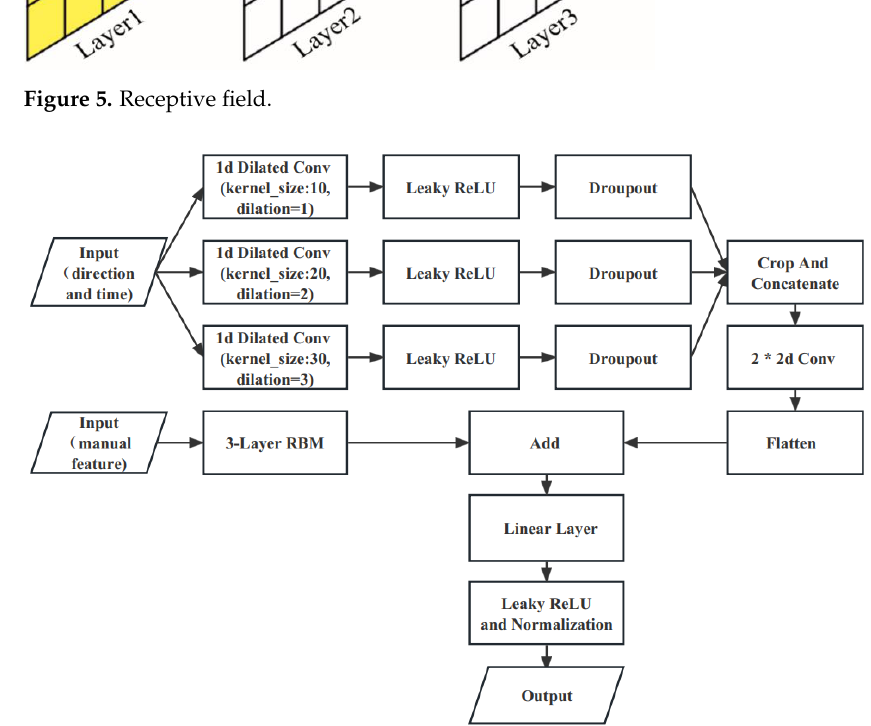
Figure 6. Parallelizing dilated convolutions